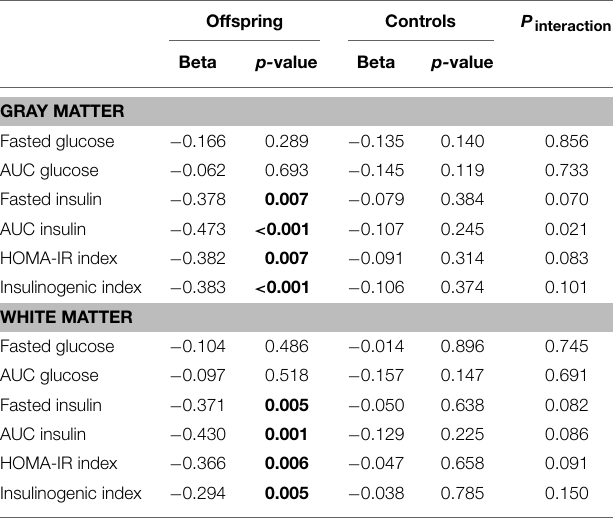
Table 3 . A visual representation of the associations according to age categories is shown in Figure 2